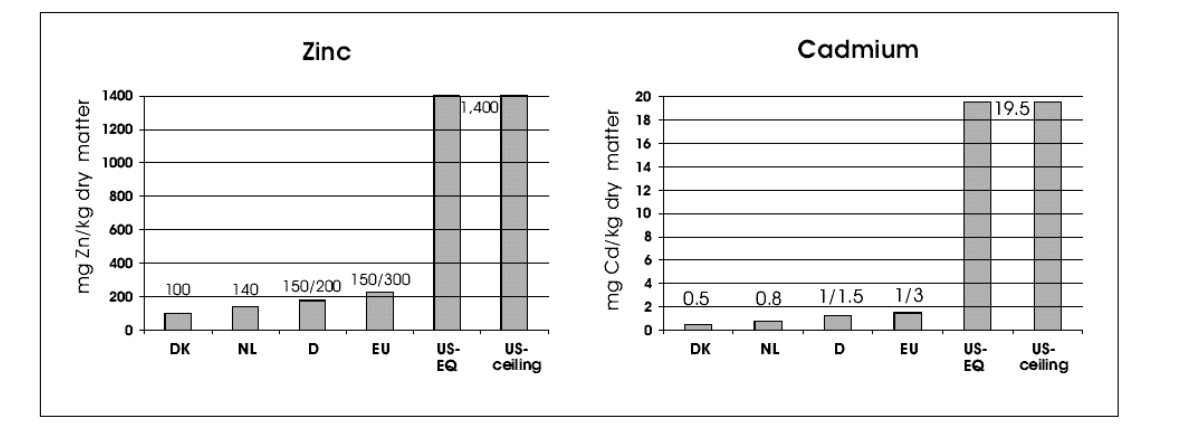
Figure 1: European and US allowable Zn and Cd soil concentrations for sites suitable for sludge application (Harrison at al., 1997 [FA4]